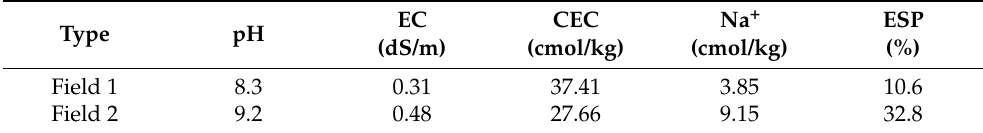
Table 1. Physical and chemical properties of the soil at the experimental